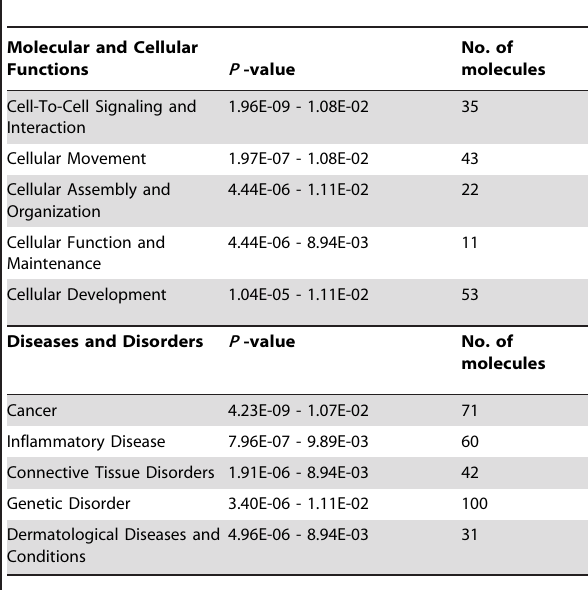
Table 3. The molecular and cellular functions and diseases and disorders associated with the consistently differentially expressed genes derived from RNA-Seq data